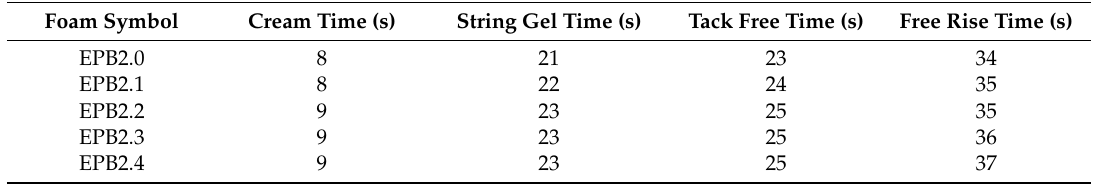
Table 4. Processing times of RPU/PIR foams with